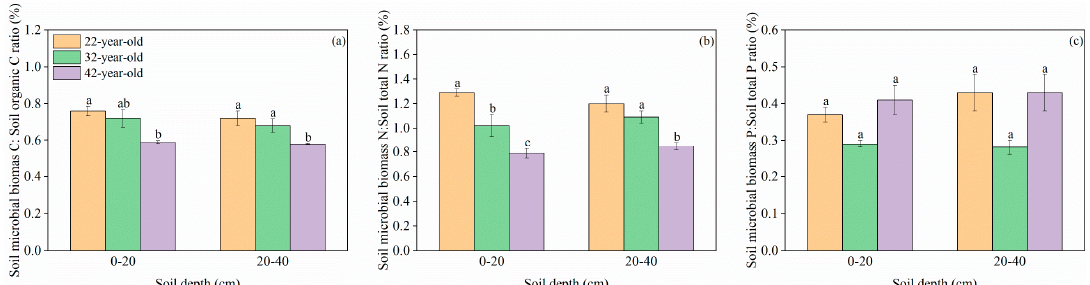
significant difference between different aged stands at the same soil horizon ( p < 0.05).